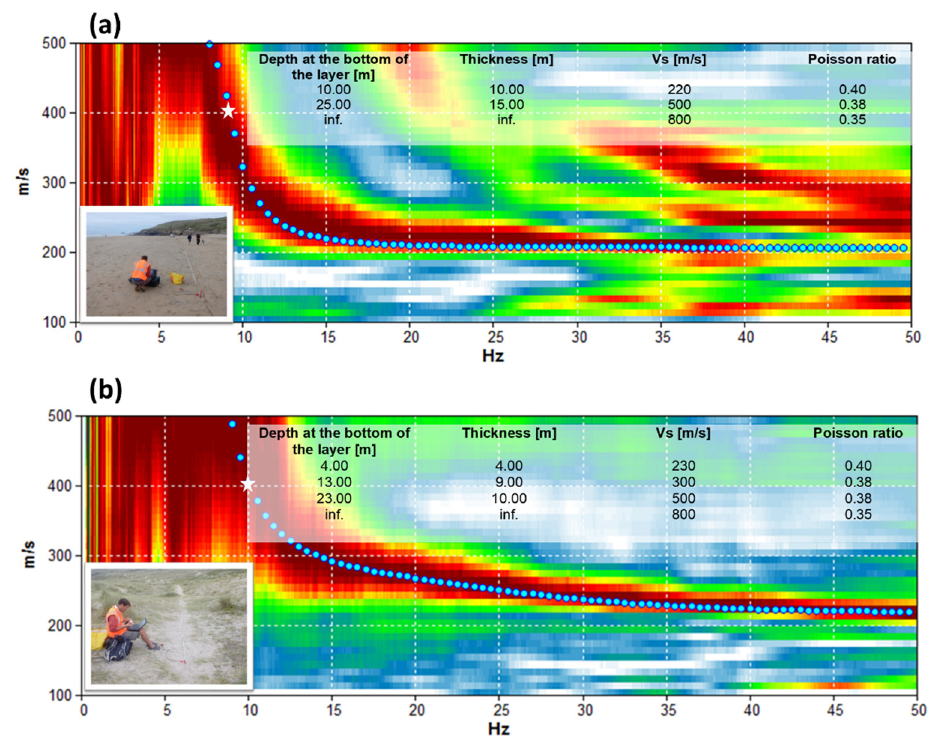
Figure 7. Phase velocity dispersion observed in the beach ( a ) and dunes ( b ) at Perran Beach on 23 August 2017. For a specified frequency, high spectral content areas are shown in red colour shades, with low spectral content shown in blue. Blue circles represent the modelled Rayleigh wave phase velocity dispersion curve. The main model parameters are indicated as a table. Thickness = inf represents the bedrock. The white star indicates the minimum frequency used to estimate the maximum depth of investigation.